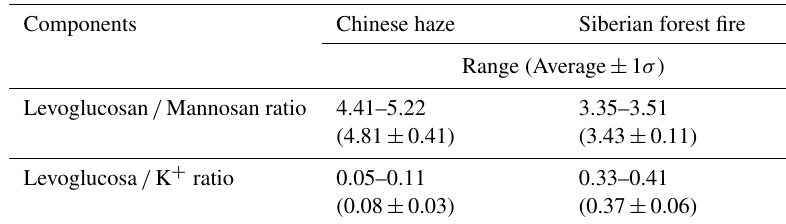
Table 3. Summary of ratios of biomass burning tracers during the Chinese haze and Siberian forest fire episodes, as measured at Daejeon, Korea in summer 2014.